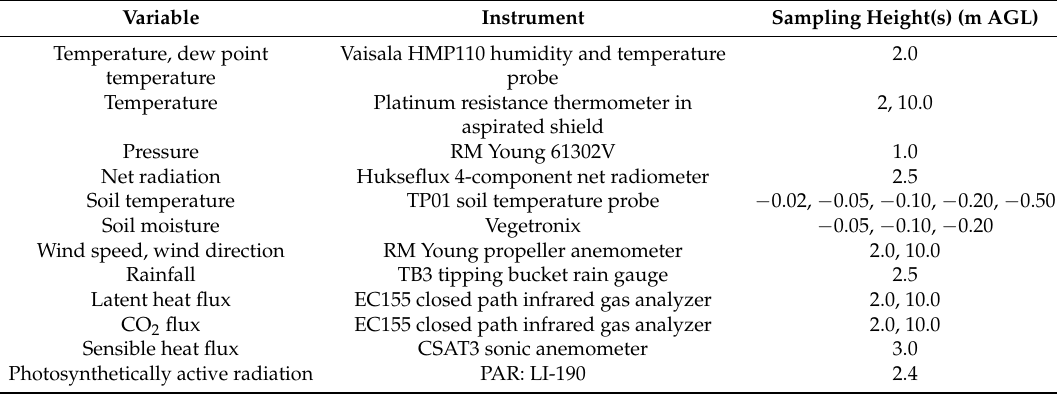
Table 3. Meteorological measurement, sampling instrument, and sampling height(s) for the variables measured at the 10 m micrometeorological tower installed at Cullman, AL during VORTEX-SE, and at the three 10-m micrometeorological towers installed during